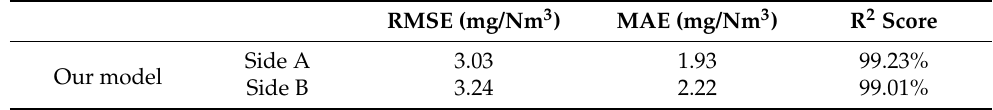
Table 4. The results of the 13th run for our